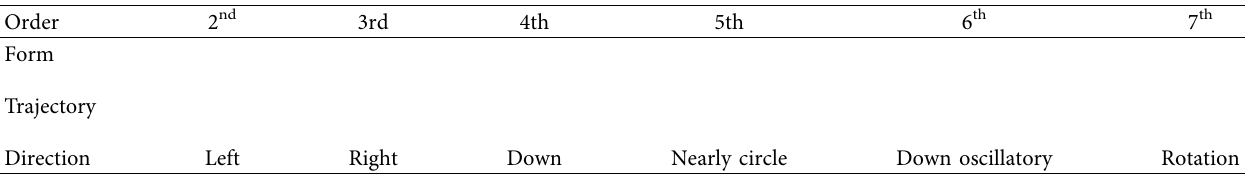
Figure 4: Hand locations for representing a letter derived from. Table 1: Different trajectories of the letter “” with all types of motion